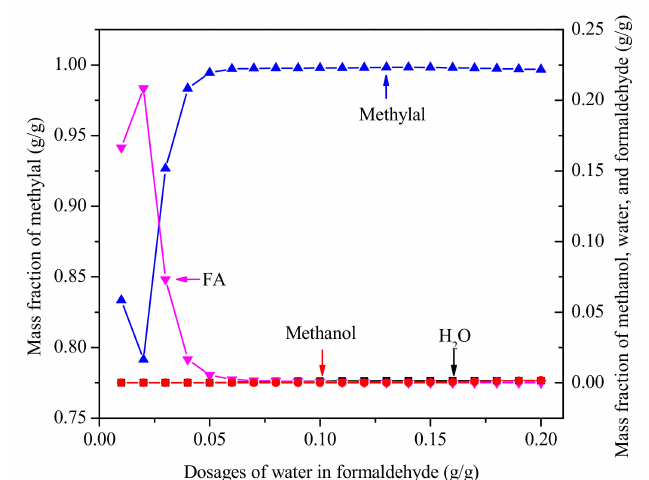
Figure 7. The purity of methylal with di ff erent water content of formaldehyde. (Methylal / CH 2 O mass ratio 2:1, N = 40, RR =